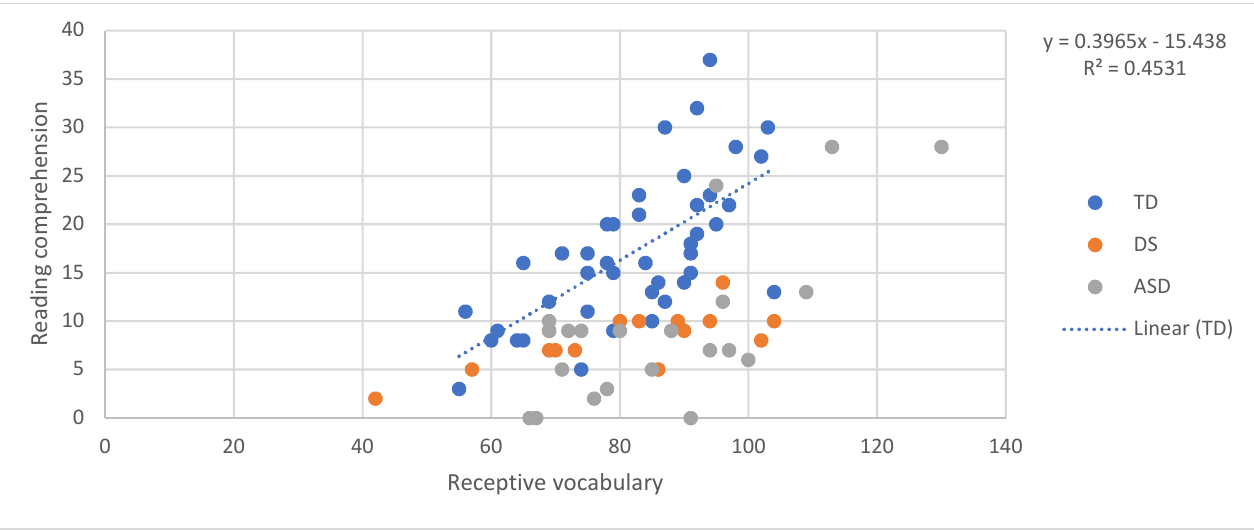
Figure 3. Receptive vocabulary predicting reading comprehension.